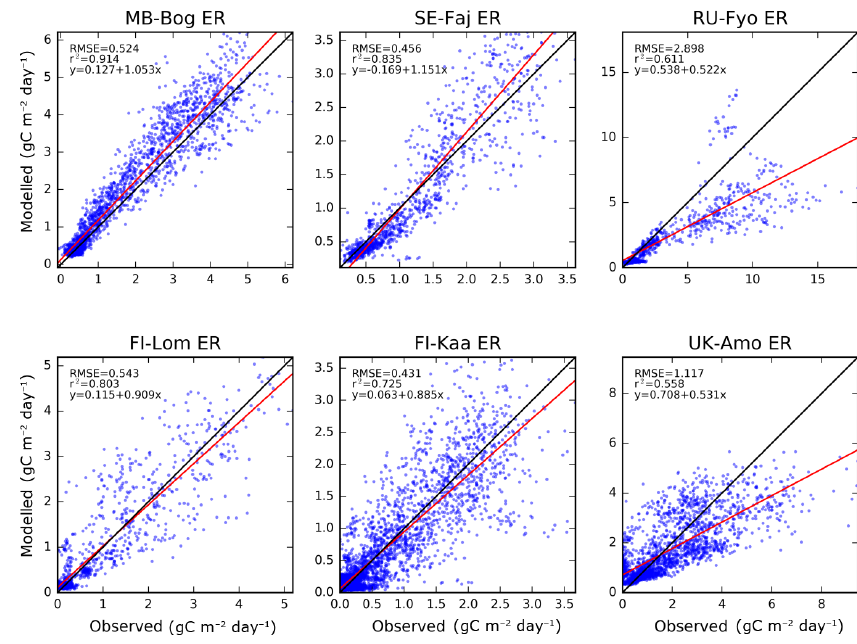
Figure 12. Scatter plots of simulated vs. observed daily ER (gCm − 2 day − 1 ) in bogs and fens.